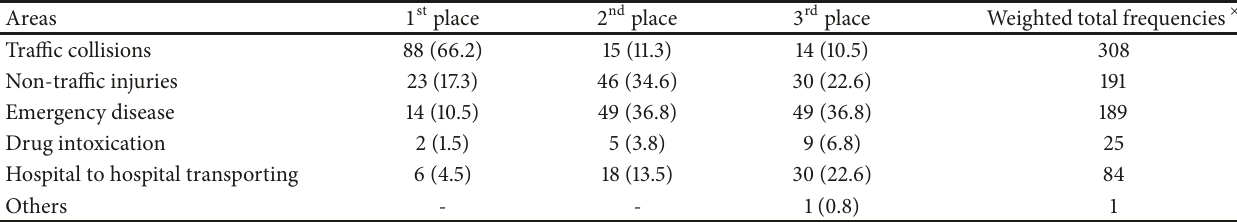
Table 1: Requirements for ambulance services (units: frequency,